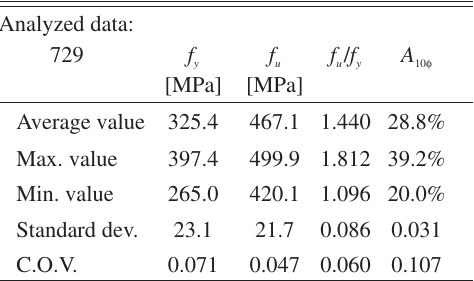
Fig. 4a,b. Steel properties distribution for the year 1960: a) yielding stress; b) ultimate elongation.